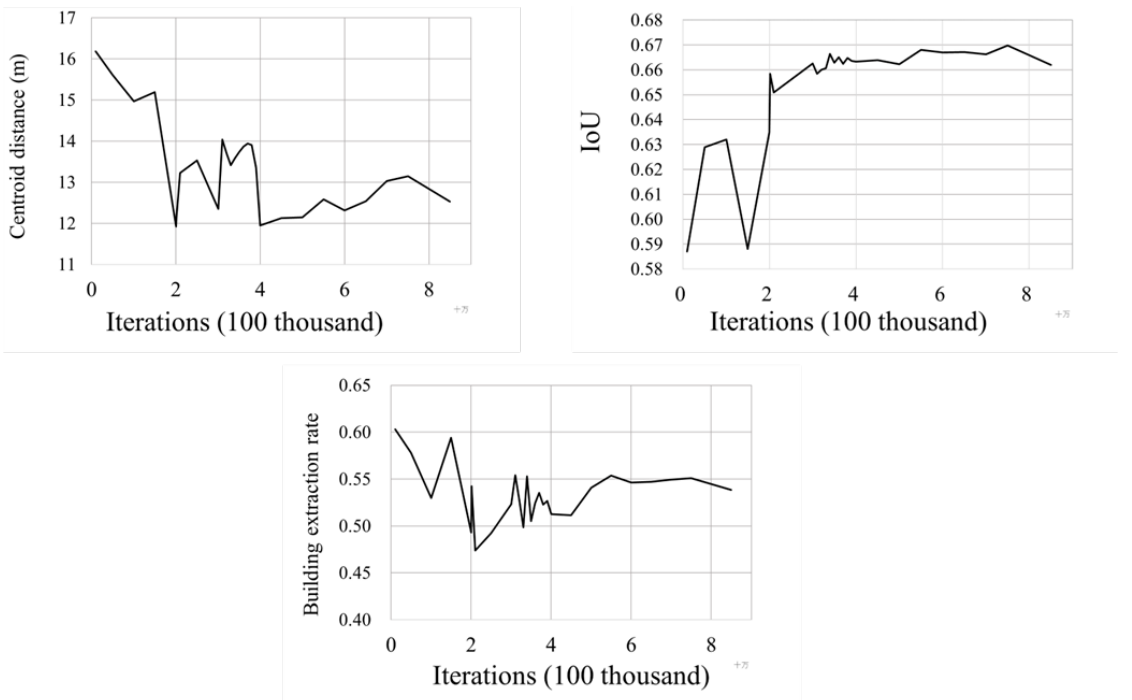
Figure 7. Relationship between iteration, centroid distance, IoU, and building extraction